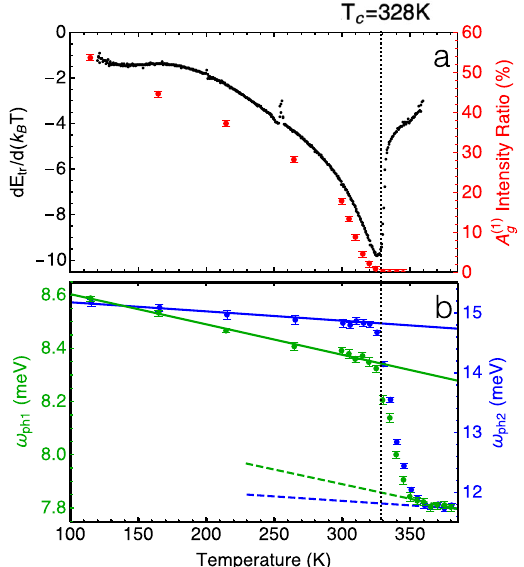
Fig. 4 Temperature dependence of the phonon parameters. a The ratio between the integrated intensity of the lowest-energy A ð 1 Þ g phonon mode in the ac and aa scattering geometries. Its appearance below T c implies the onset of symmetry breaking that mixes the responses in aa and ac geometries. For comparison, the temperature derivative of the transport activation gap E tr ð T Þ ¼ is shown in black, displaying a discontinuity at T c Error bars are the standard deviation. b The temperature depen- dence of the frequency of the two lowest-energy optical phonon modes ω ph 1,2 in ac geometry, that exhibit strong coupling with the excitonic continuum. Error bars are the 95% con fi dence intervals of the Fano model fi t. The phonon frequencies soften on heating consistent with anharmonic decay model (solid lines) below T c and above 350 K (see Supplementary Note 1.3.3 for details). The more pronounced change between this regimes is attributed to a nonlinear exciton-phonon coupling, not included in the Fano model (see